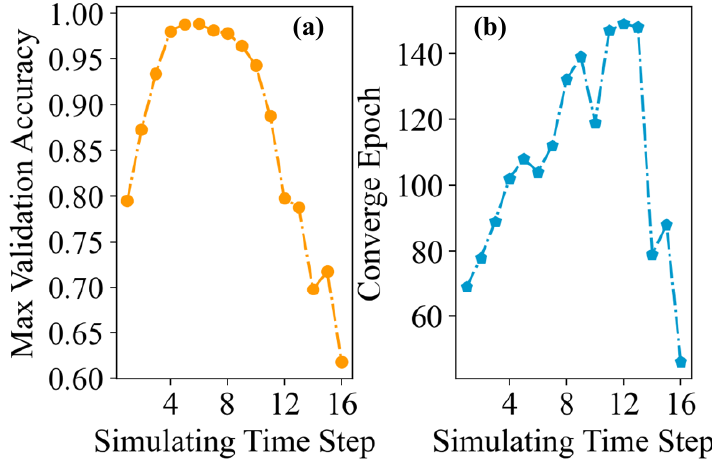
Figure 8. The effects of observation time T on the ( a ) validation accuracy and ( b ) convergence epoch.